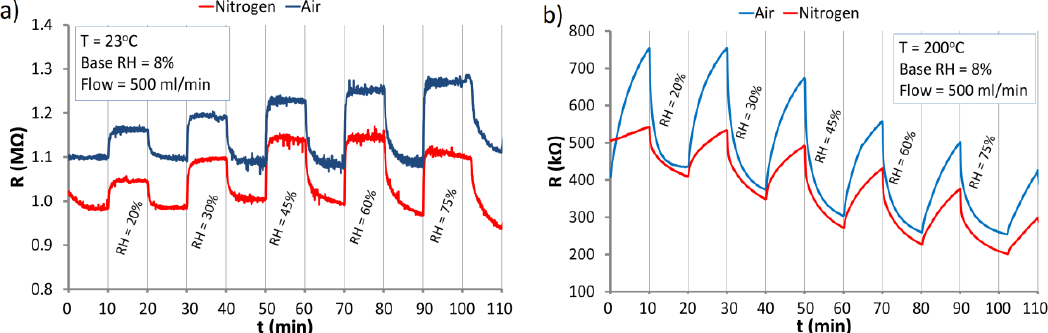
Figure 14. Reaction of the ZnO nanostructures to changes of the relative humidity (RH) level under atmospheres of nitrogen and air at: ( a ) RT; ( b ) 200 °C.